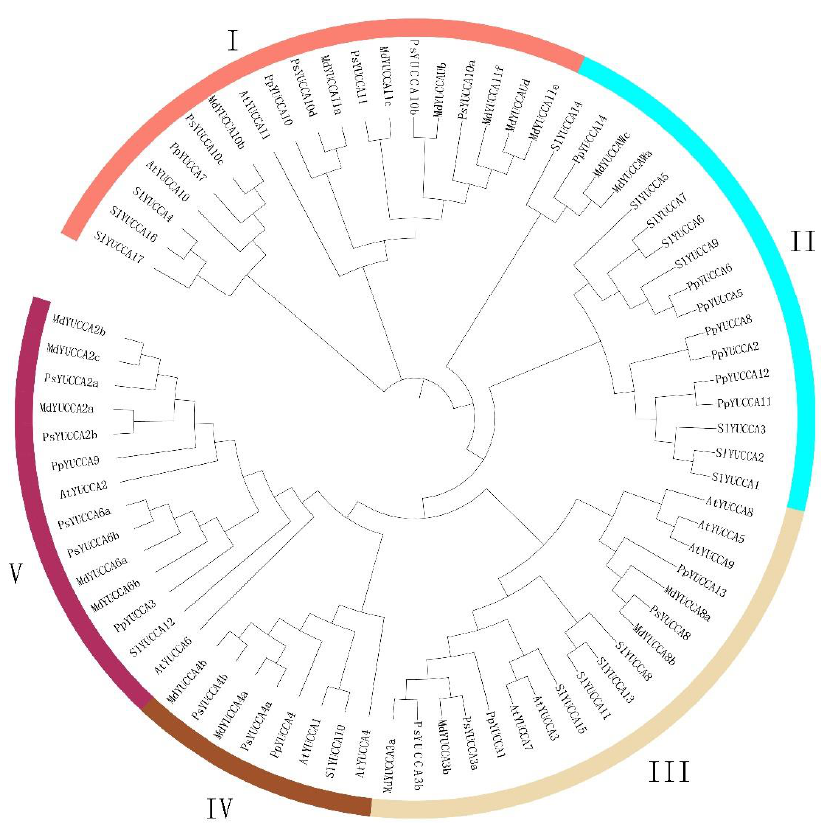
Horticulturae 2022 , 8 , 878 Figure 5. Phylogenetic tree of YUCCA genes in Prunus persica var. pendula. At— Arabidopsis thaliana ; Figure 5. Phylogenetic tree of YUCCA genes in Prunus persica var. pendula. At — Arabidopsis thali- ana ; Md — Malus domestica ; Ps — Pyrus bretschneideri ; Sl — Solanum lycopersicum ; Pp — Prunus persica Md— Malus domestica ; Ps— Pyrus bretschneideri ; Sl— Solanum lycopersicum ; Pp— Prunus persica var. pendula. var. pendula.